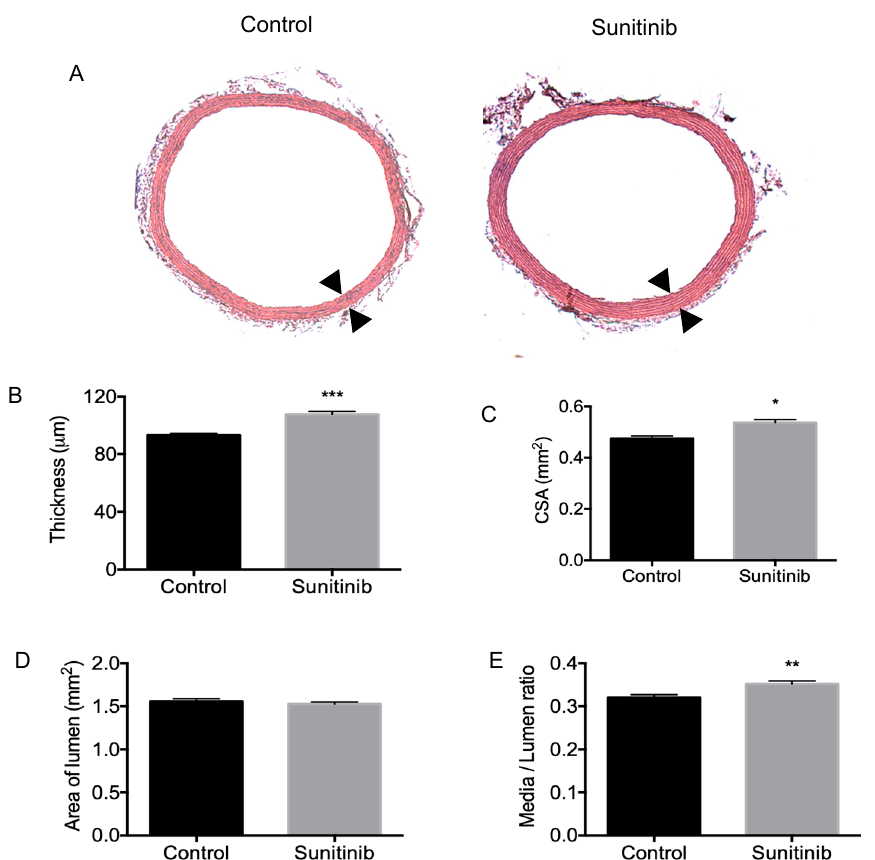
Figure 3. Aorta thickness ( A and B ; delimited by arrowheads), cross-sectional area (CSA) of tunica media ( C ), lumen area ( D ) and media/lumen ratio ( E ) in control and Su-treated (25 mg/kg/day) animals. Magnification: 10×. Values are expressed as mean ± S.E.M. of six animals per group. * p < 0.05; ** p < 0.01; *** p < 0.001 vs. control group.